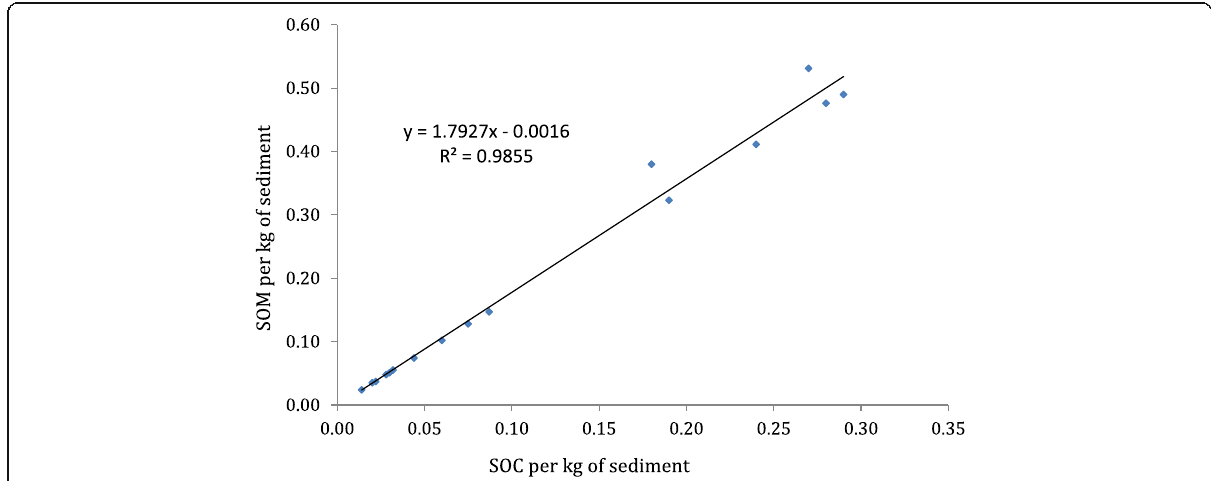
Fig. 4 the correlation between SOC and SOM contained in a kilogram of sediment collected from fourteen